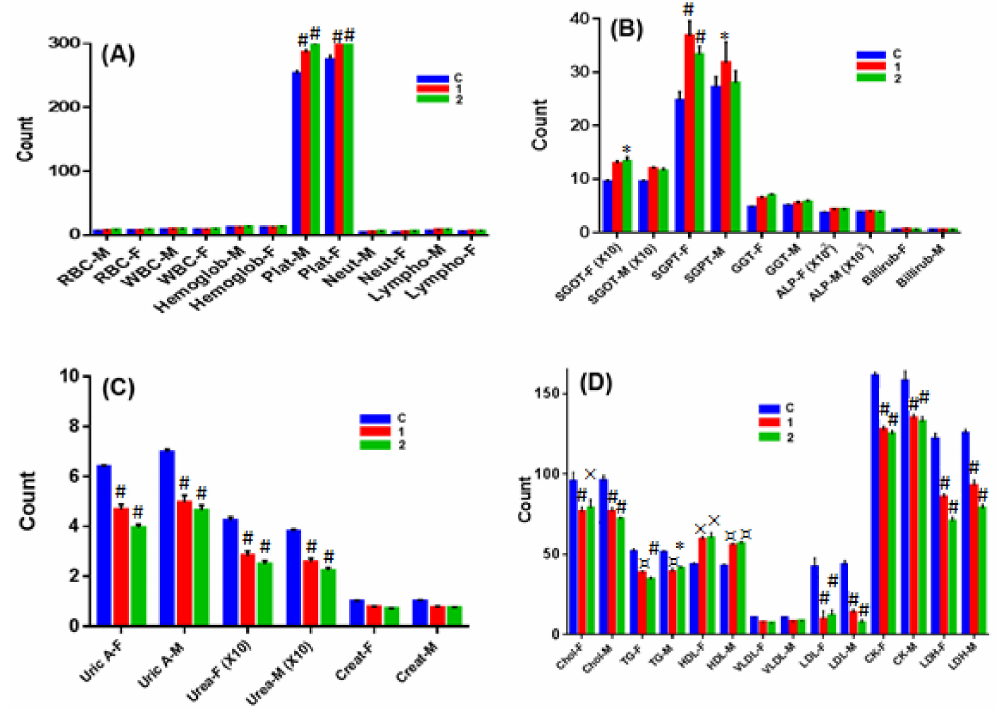
Figure 10. Chronic toxicity profile of complexes 1 and 2 . Effect of complexes 1 and 2